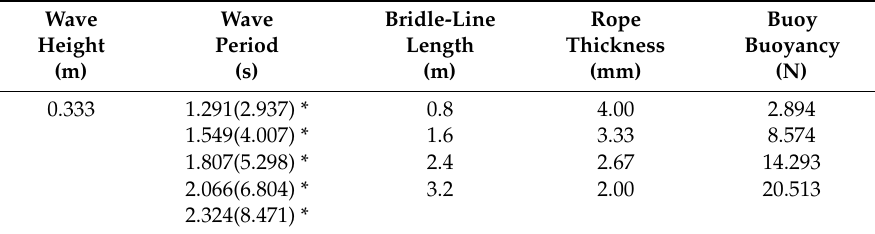
Table 2. Conditions for waves and mooring included in the